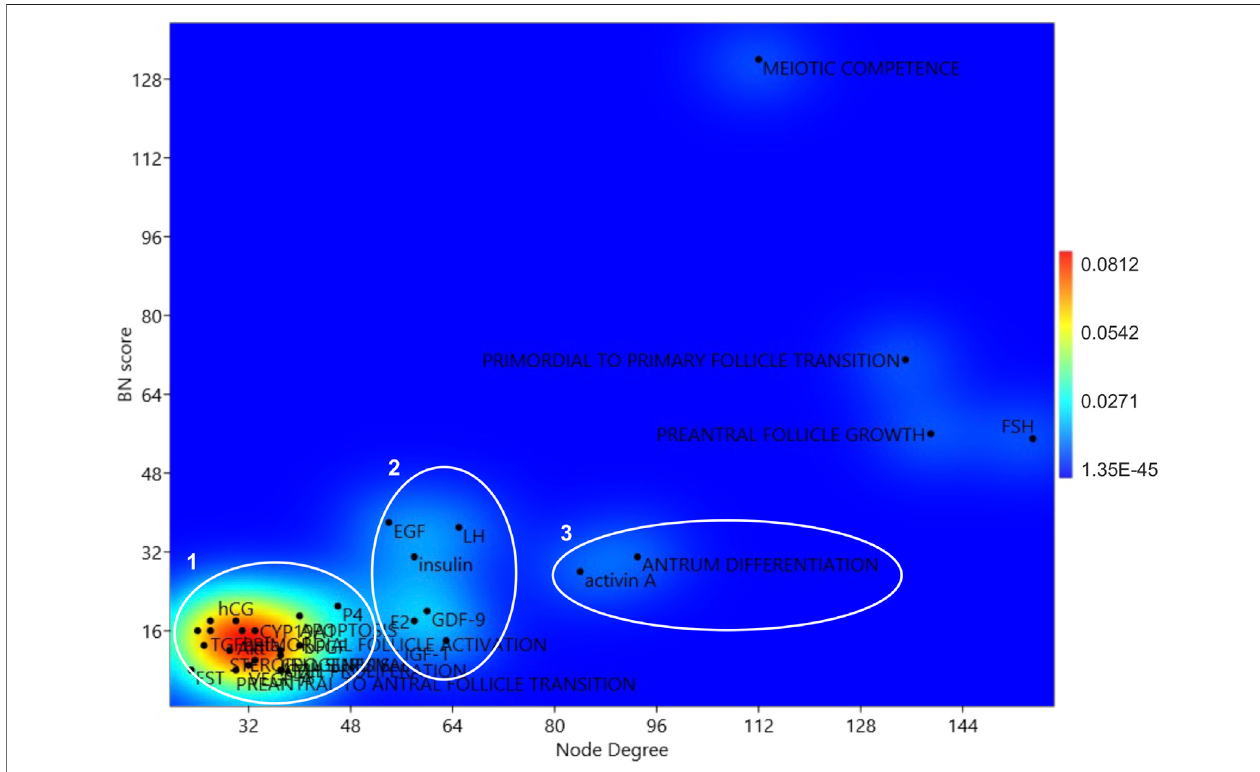
FIGURE 2 | KDE 2D analysis of the network hubs. Centrality parameters of BN and node degree parameters of the hub.BN were considered for the 2D KDE